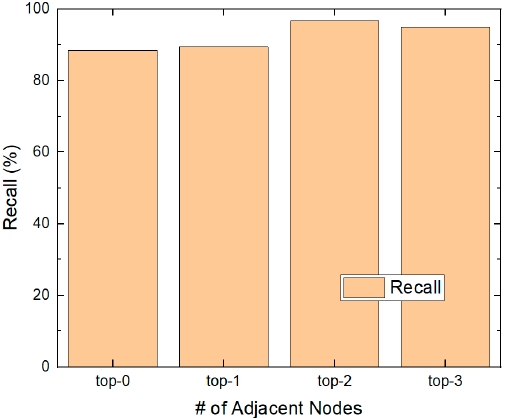
Figure 7. Recall (Detection rate) according to the number of adjacent nodes.